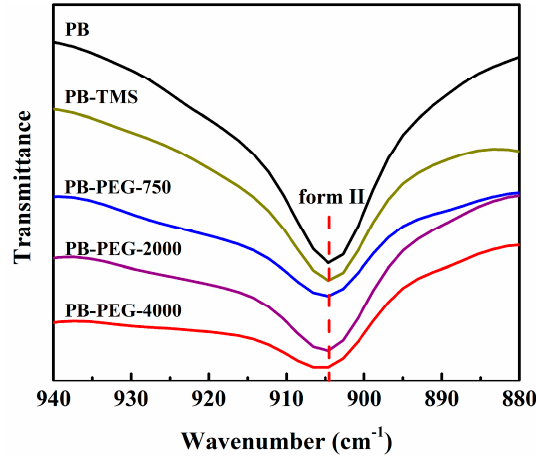
Figure 2. Fourier transform infrared spectroscopy (FTIR) spectrum of the PB, PB-TMS, and PB-PEG copolymers crystallized during cooling at 10 ◦ C /